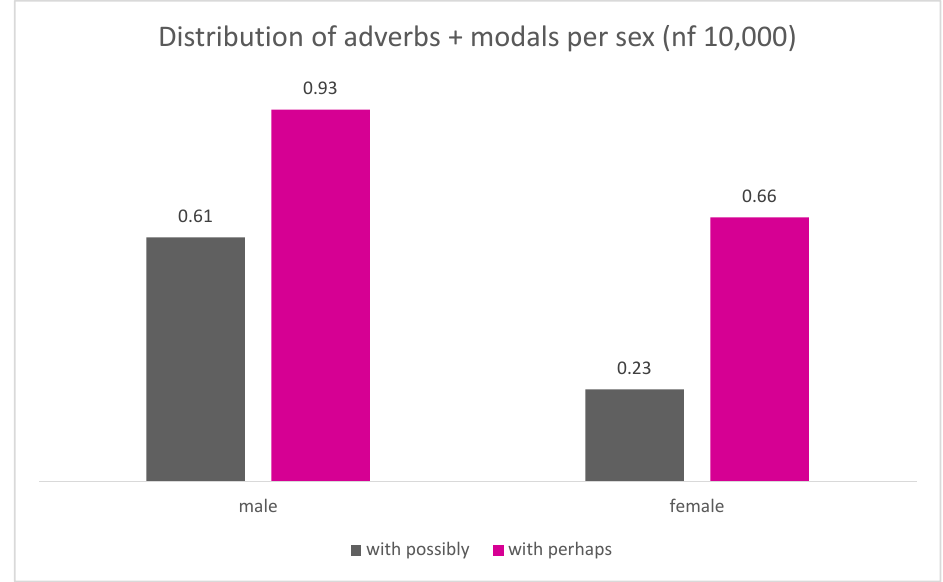
Figure 5. Use of perhaps and possibly per sex.